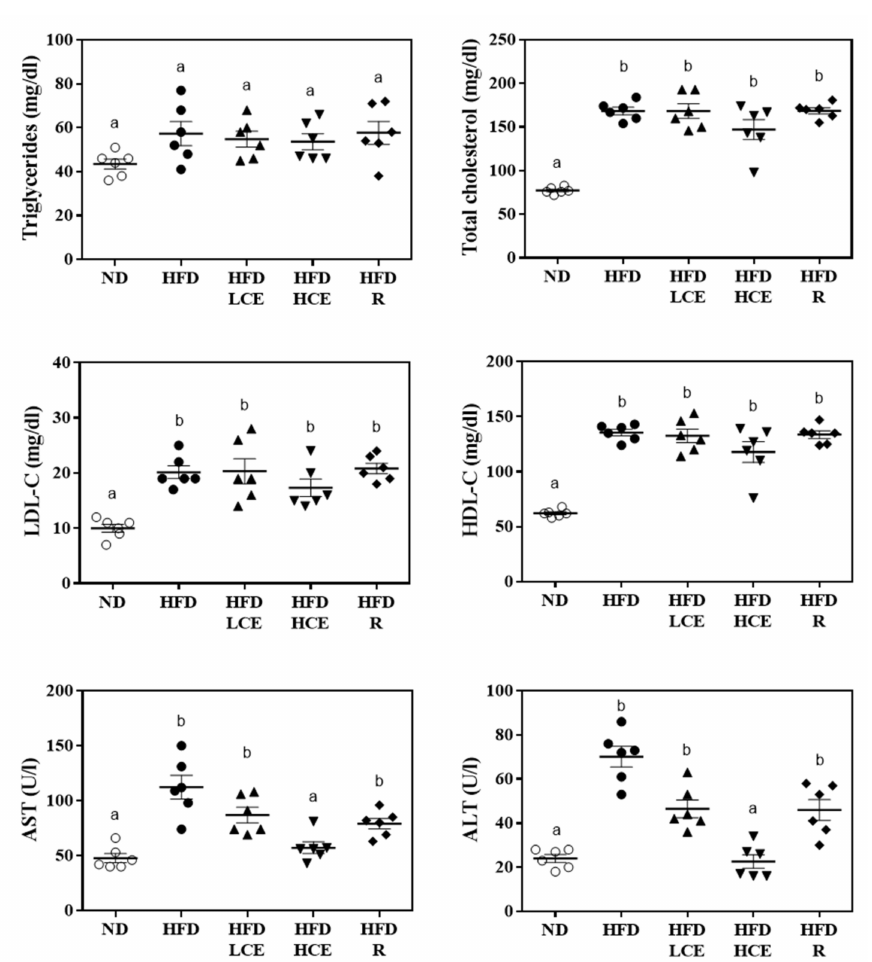
Figure 3. Effect of Djulis hull crude extract and rutin on blood biochemistry in HFD-induced obese mice. ND: normal diet; HFD: high-fat diet; LCE: low dosage of crude extract; HCE: high dosage of crude extract; R: rutin; LDL-C: low-density lipoprotein cholesterol; HDL-C: high-density lipoprotein cholesterol; AST: aspartate aminotransferase; ALT: alanine aminotransferase. Values represent the mean ± SEM (n = 6). Statistical methods were used by one-way ANOVA, and the different superscript letters are significantly different at p <